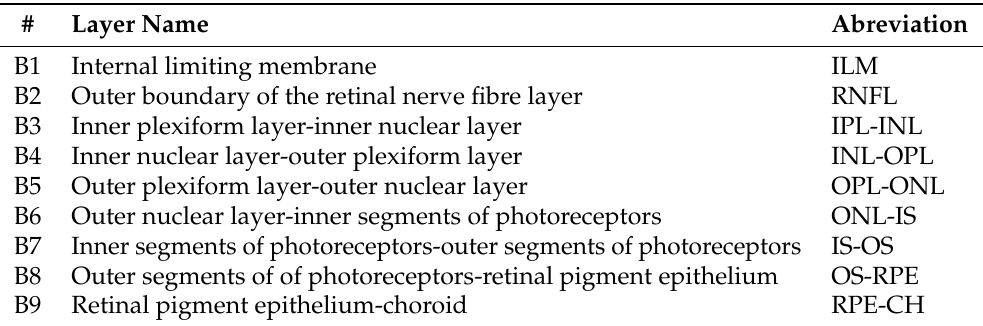
Figure 1. Retina segmentation from an OCT B-Scan image. Table 1. Nine layers in the